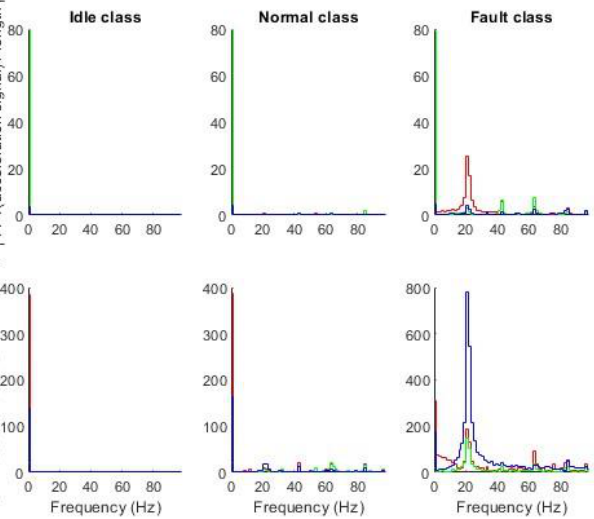
Figure 12. Accelerometer and gyroscope frequency domain data in 3-axis: red— X , green— Y , and blue— Z .